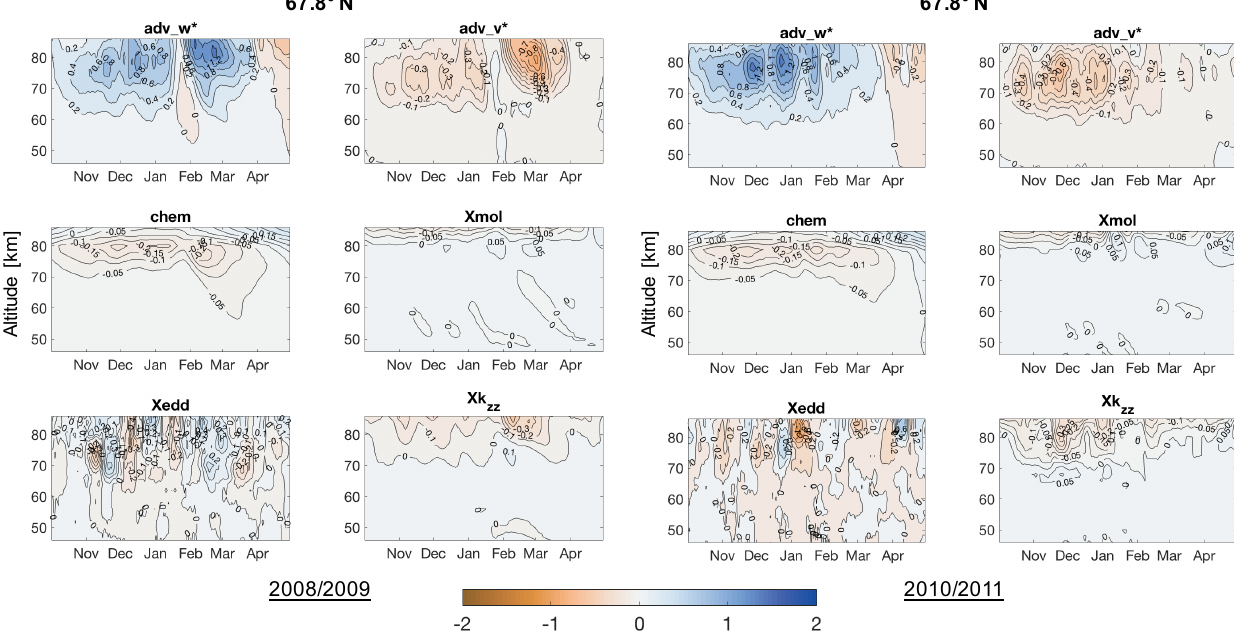
Figure 3. 11-day running mean tendencies of CO (in ppmvday − 1 ), calculated using daily averaged SD-WACCM output. Tendencies shown are for 67.8 ◦ N for the winters of 2008/2009 and 2010/2011. See Sect. 3.1 for a description of the tendencies, which are represented in the TEM continuity equation. Note that the labelled contours may be differently spaced in each panel, to match the range of values for individual